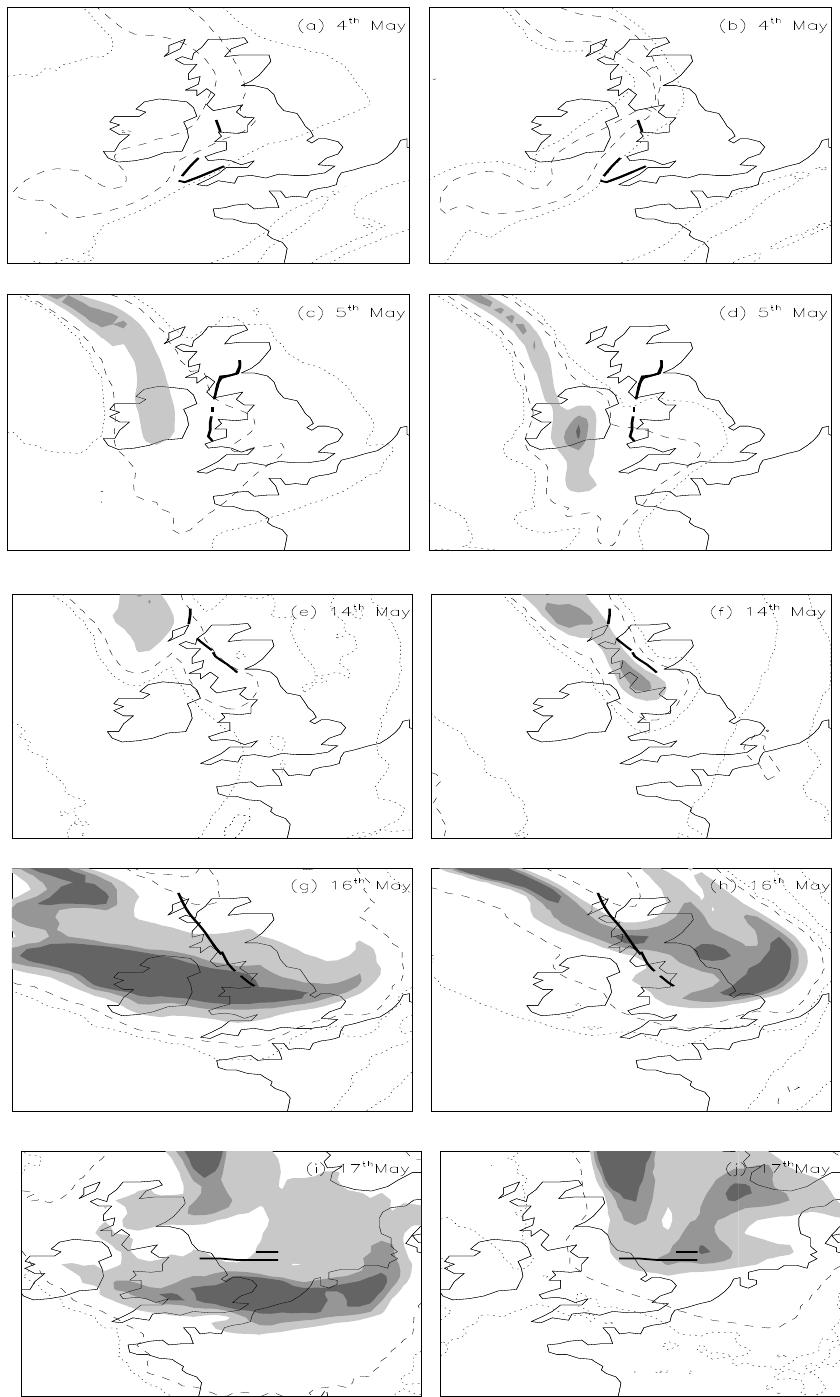
Fig. 4. Maps showing the column integrated mass loadings simulated by NAME. The figures on the left show simulations where the emission profiles is uniform between the top of the volcano and the top of the eruption plume, figures on the right are for an emission profile concentrated at the top of the eruption plume. The dotted contour corresponds to a column integrated mass loading of 0.02 g m − 2 and the dashed contour 0.2 g m − 2 . The filled contours show 10, 20 and 30 g m − 2 (note these concentrations do not account for fall out of ash near the volcano). The thick black lines mark the locations of the ash features analysed in the text.